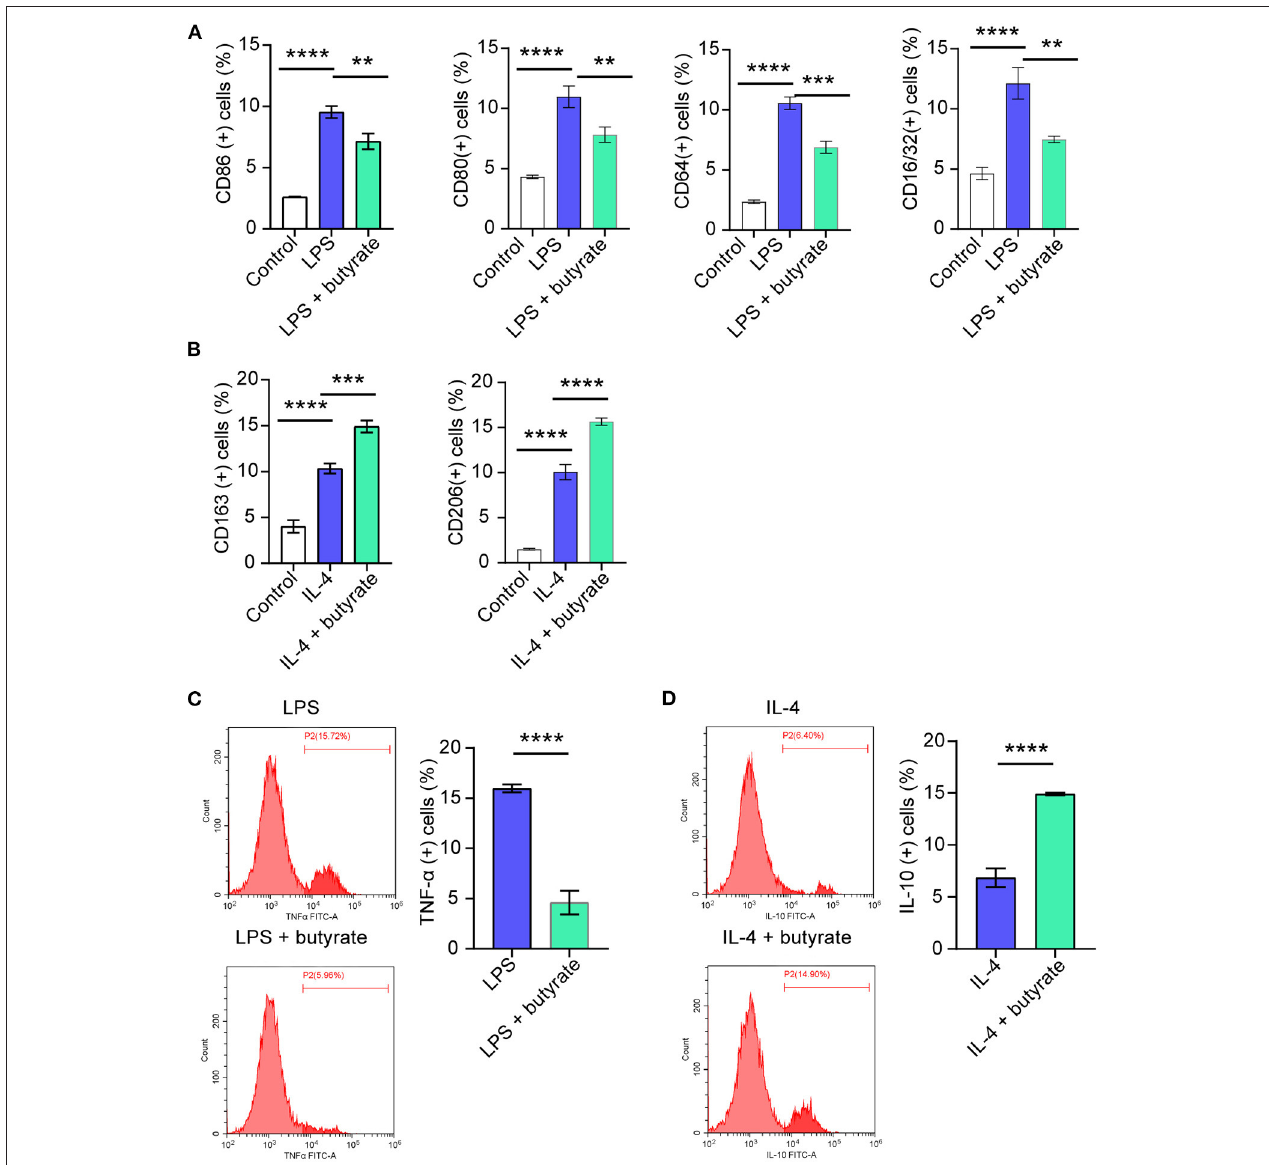
FIGURE 3 | Influences of butyrate on M1/M2 polarization of rat macrophages RMa-bm. (A–D) . Flow cytometry was performed to detect CD86 ( + ), CD80 ( + ), CD64 ( + ), CD16/32 ( + ), CD163 ( + ), CD206 ( + ), TNF- α ( + ), and IL-10 ( + ) positive cell rates in different treatment groups, respectively. ** P < 0.01, *** P < 0.001, **** P <